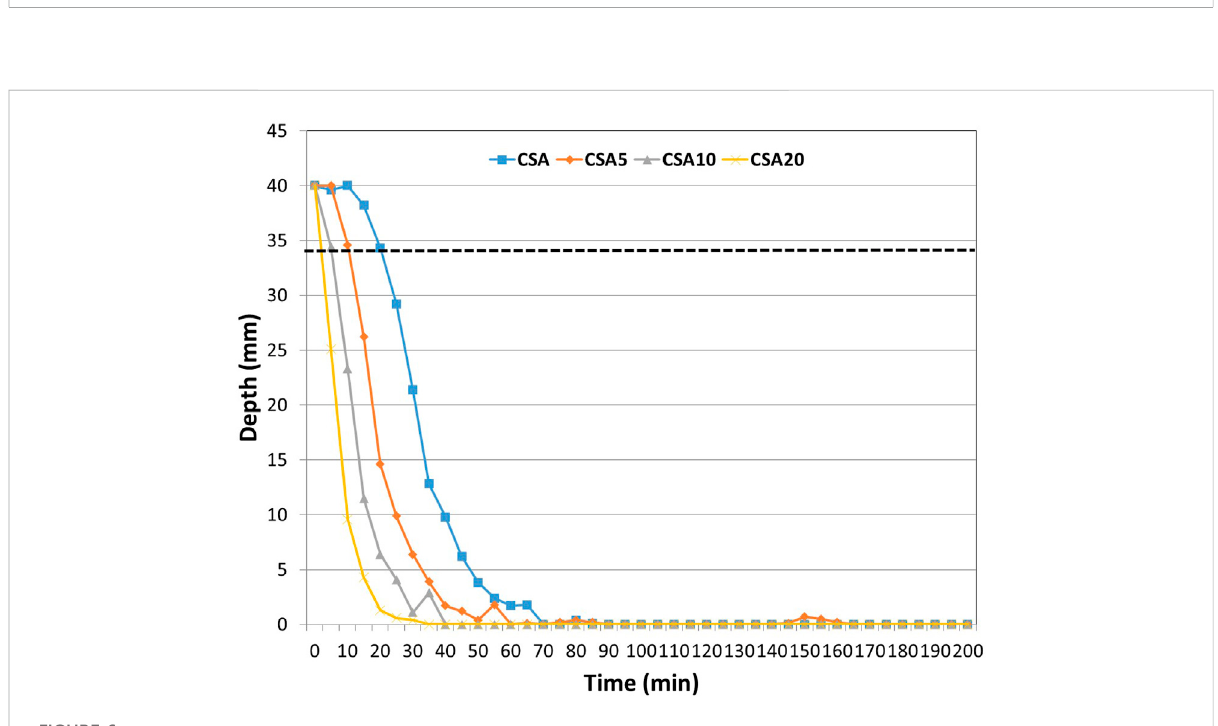
FIGURE 6 Setting time of the four mix